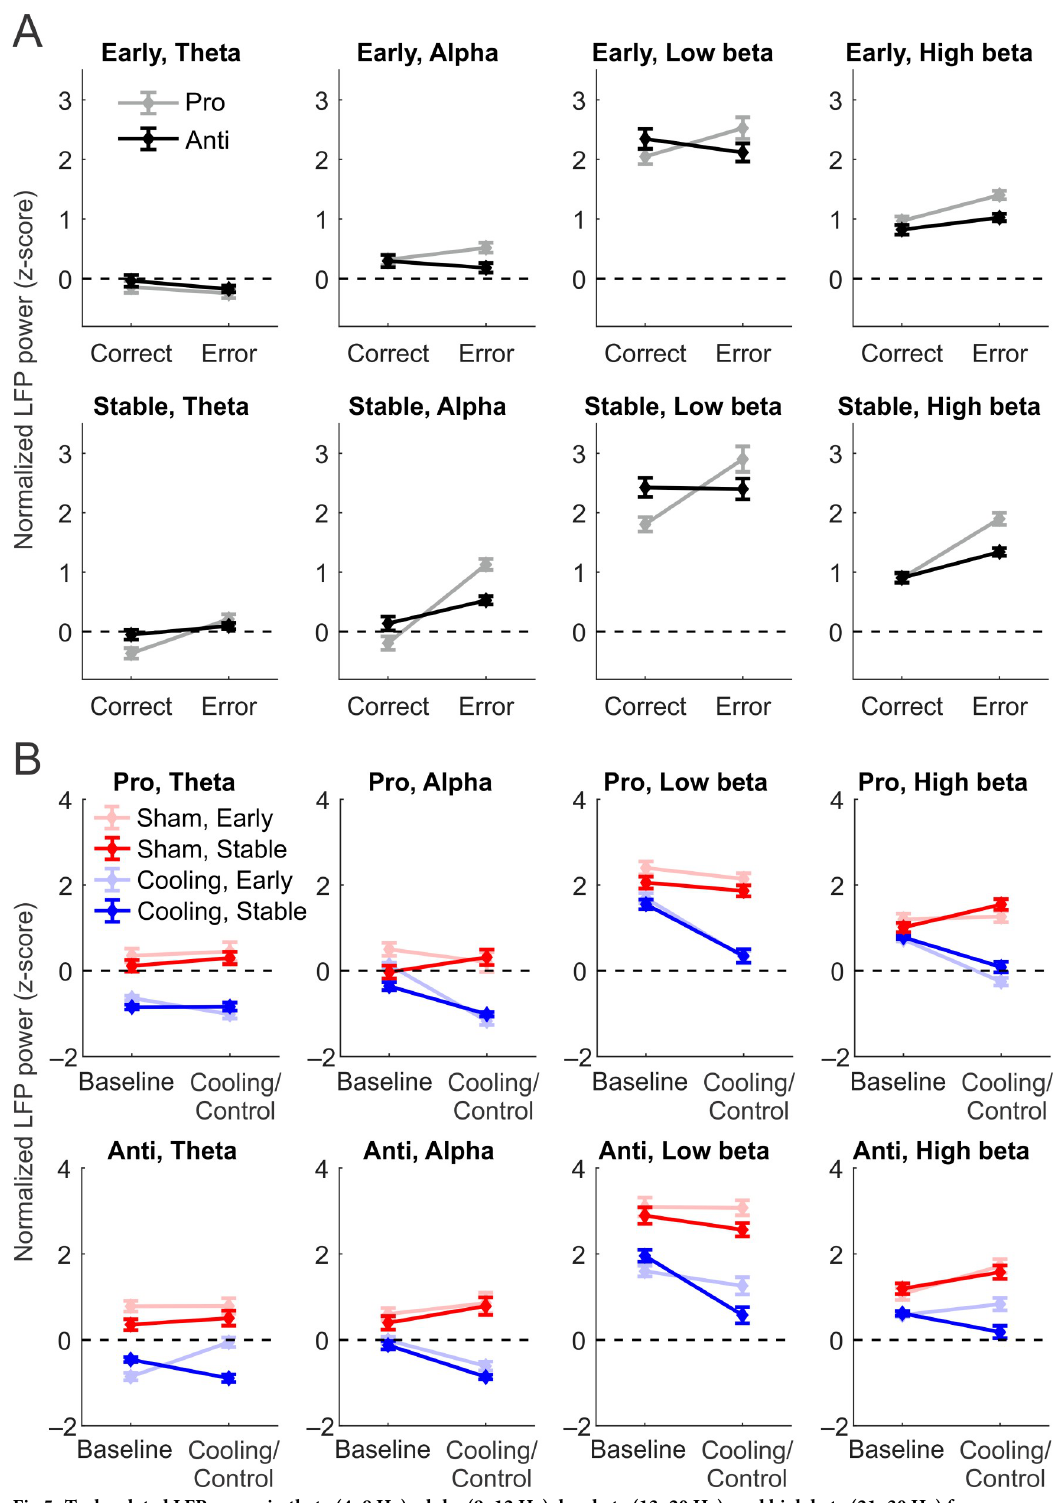
Fig 5. Task-related LFP power in theta (4–8 Hz), alpha (9–12 Hz), low beta (13–20 Hz), and high beta (21–30 Hz) frequency bands in correct trials under different rules and post-switch stages. In each frequency band, LFP power during fixation periods was standardized against LFP power during ITIs. See S6 and S7 Tables for complete sets of result from statistical tests. (A) Averaged normalized LFP power preceding correct (left symbols in each plot) versus error (right symbols) responses at the Early